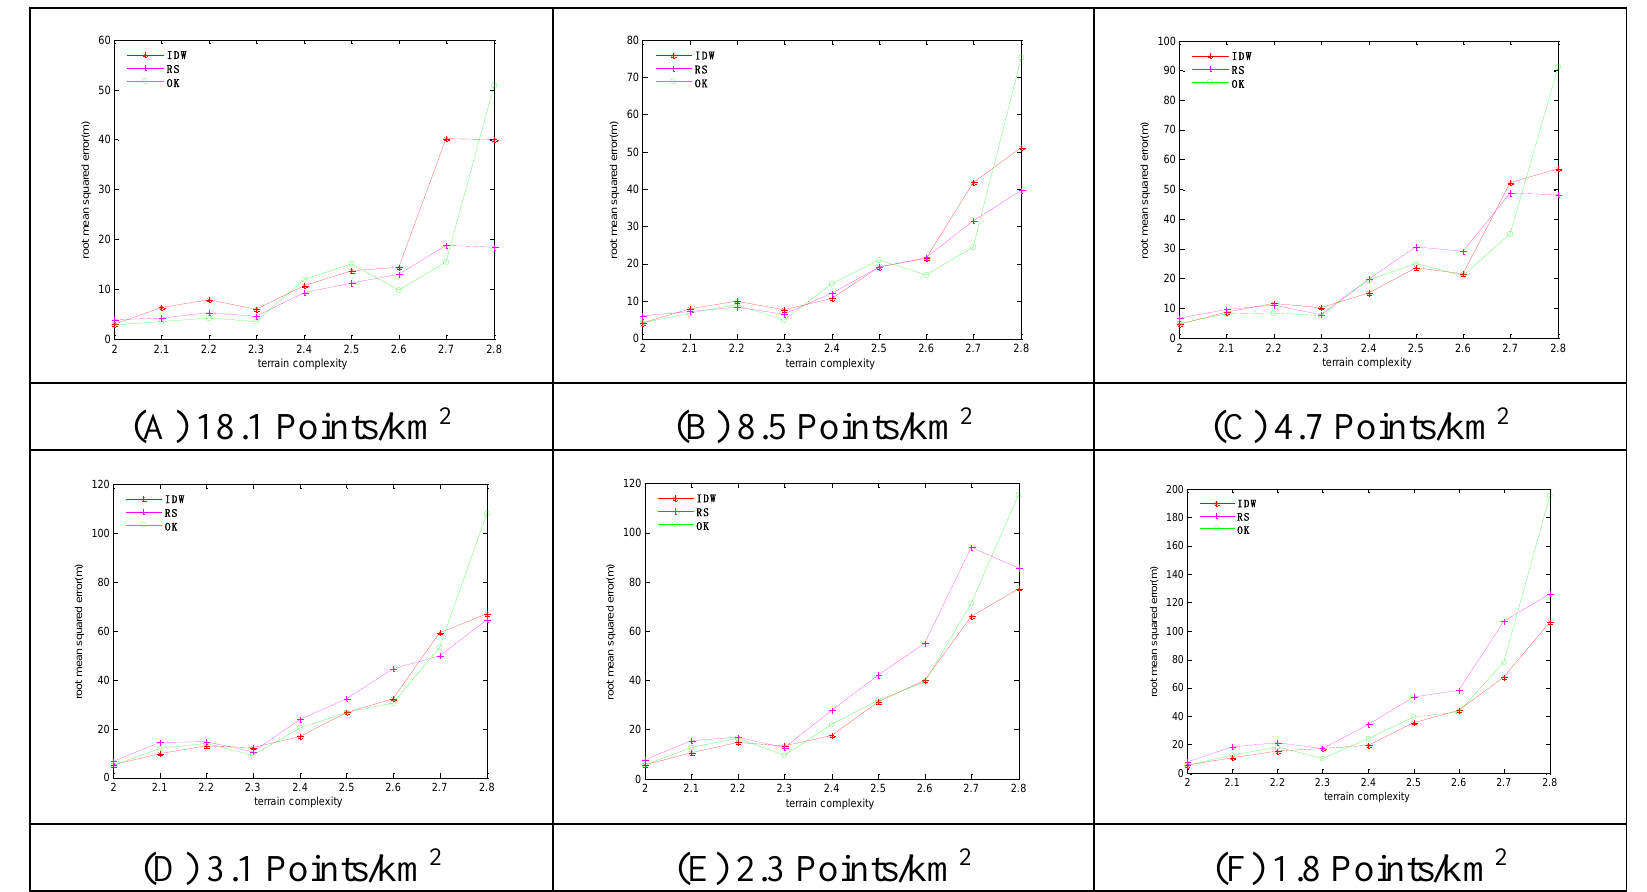
Figure 7. The RMSE s of the 3 methods in selective sampling. Sampling densities of ( A ) 18.1 points/km 2 ; ( B ) 8.5 points/km 2 ; ( C ) 4.7 points/km 2 ; ( D ) 3.1 points/km 2 ; ( E ) 2.3 points/km 2 ; ( F ) 1.8 points/km 2